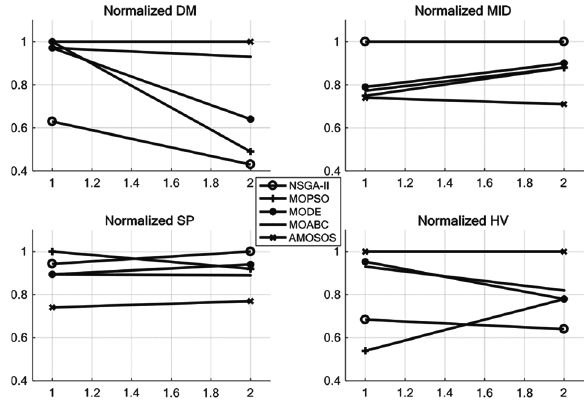
Table 5. The pairwise comparisons matrix of the metrics Metric